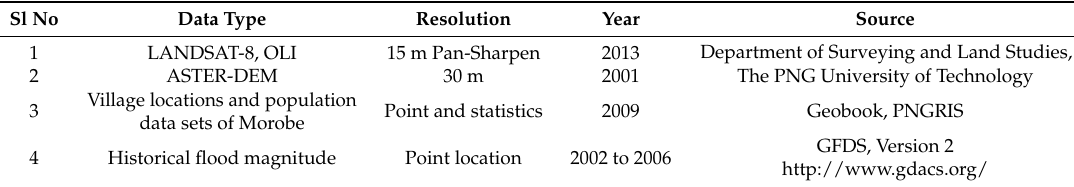
Table 1. Data sets used for Identification of possible flood risk